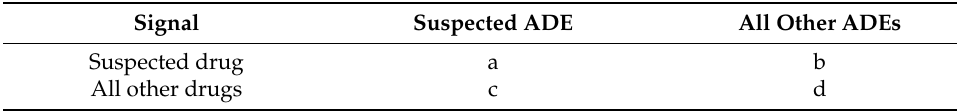
Table 1. Two-dimensional contingency table of ADRs. Signal Suspected ADE All Other ADEs Suspected drug b All other